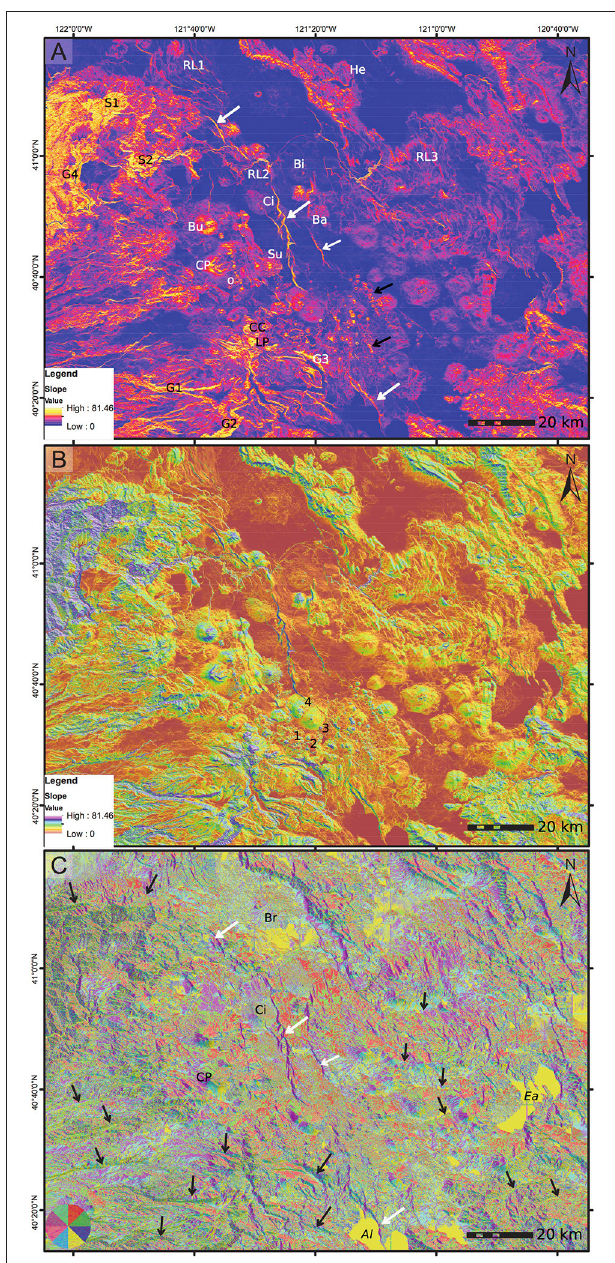
FIGURE 3 | Slope and aspect maps (Gesch et al., 2002). (A) Density sliced slope map where steep areas including volcano and cone summits and fault scarps are yellow, edifices are pink, and relatively flat surfaces and water bodies are blue. The boundaries between the blue and pink areas are the break in slopes that mark a volcano base. Arrows are drawn perpendicular to the general strike of the lineaments. Fault groups based on orientation and strike, degree of curvature and sinuosity are RL1, RL2, RL3. Hat Creek Fault and its projected continuation is shown by thick white arrow. McArthur fault is indicated by a thin white arrow. Steep gorges are marked G1, G2, G3, and G4. Steeply sloping, wide areas are S1 and S2. Stratovolcanoes with known and observed deformed edifices are Crater Peak (CP), Chaos Crags (CC) and Lassen Peak (LP). Other edifices are Sugarloaf Peak (Su), Cinder Butte (Ci), Big Cave (Bi), Bald Mountain (Ba), and Burney Mountain (Bu) and lava fields (o)